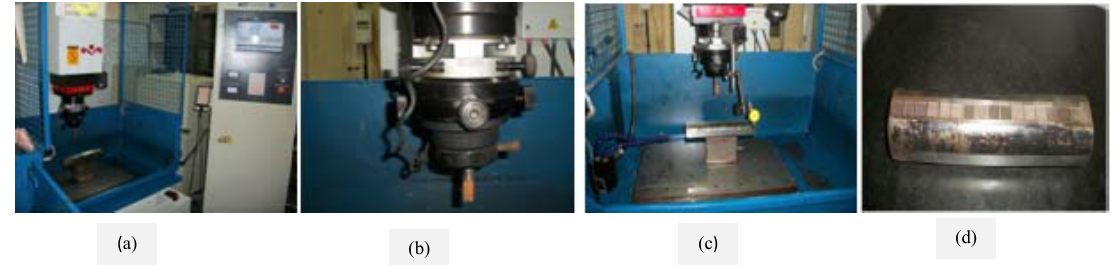
Fig. 1. (a) Working Tank with work holding (b) Tool holding devices (c) Tool holder (d) Work piece